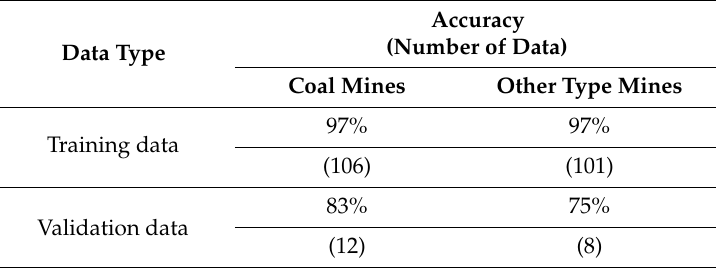
Table 2. Accuracy of analysis A by the data